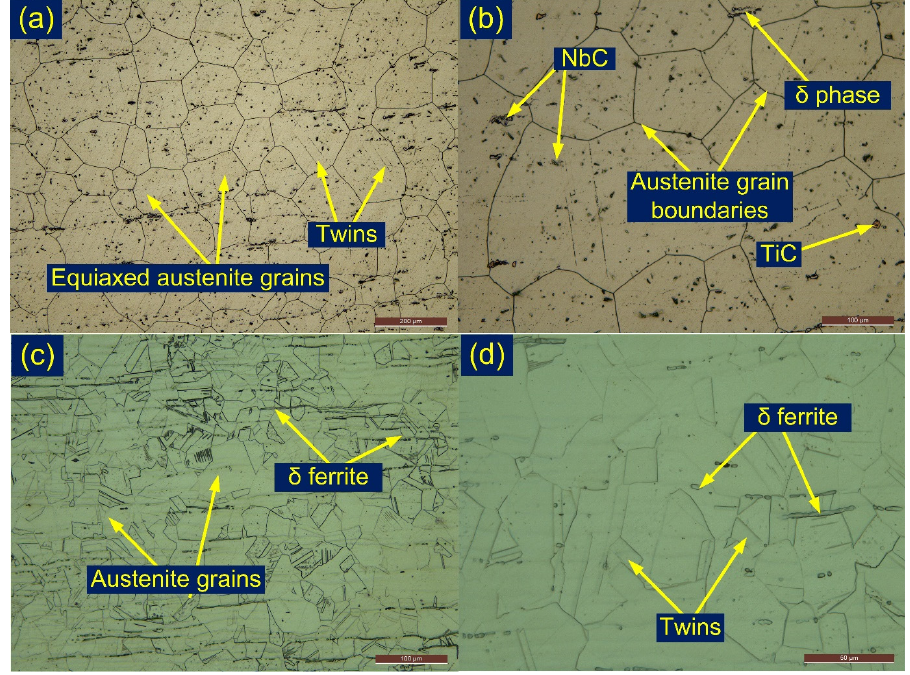
Figure 1. Optical image at low and high magnification ( a , b ) Inconel 718, ( c , d ) 304L SS.